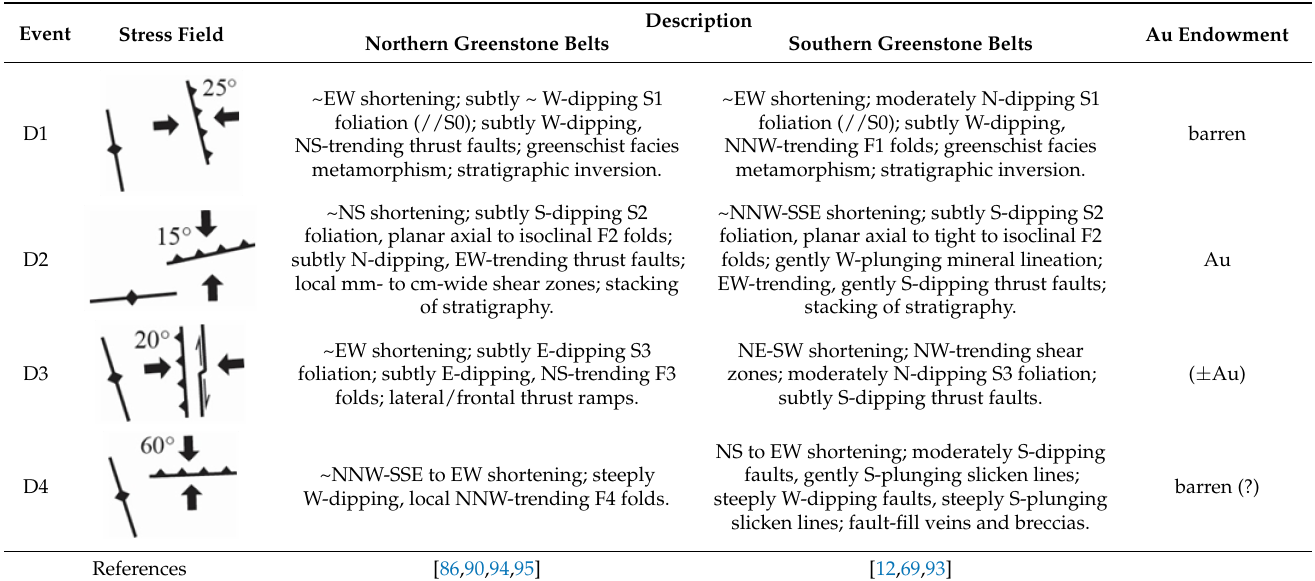
Table 3. Deformation events proposed for the